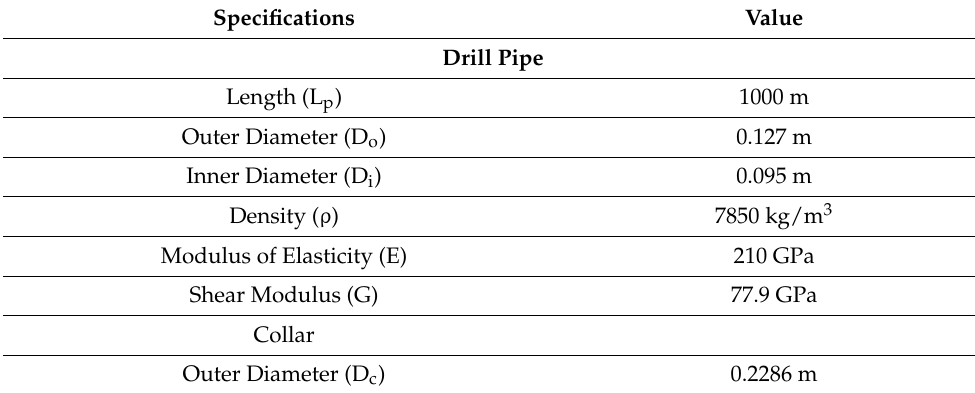
Table 1. Main physical and geometrical parameters of the drill-string under consideration (Khulief et al. [8,15]).